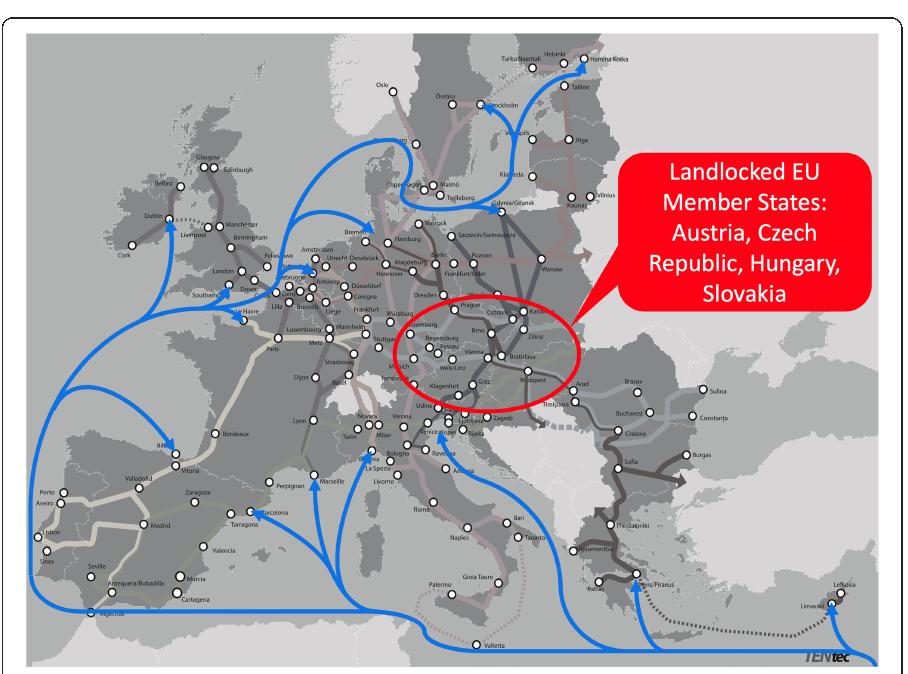
Fig. 7 The rail alternatives to shipping (Steer